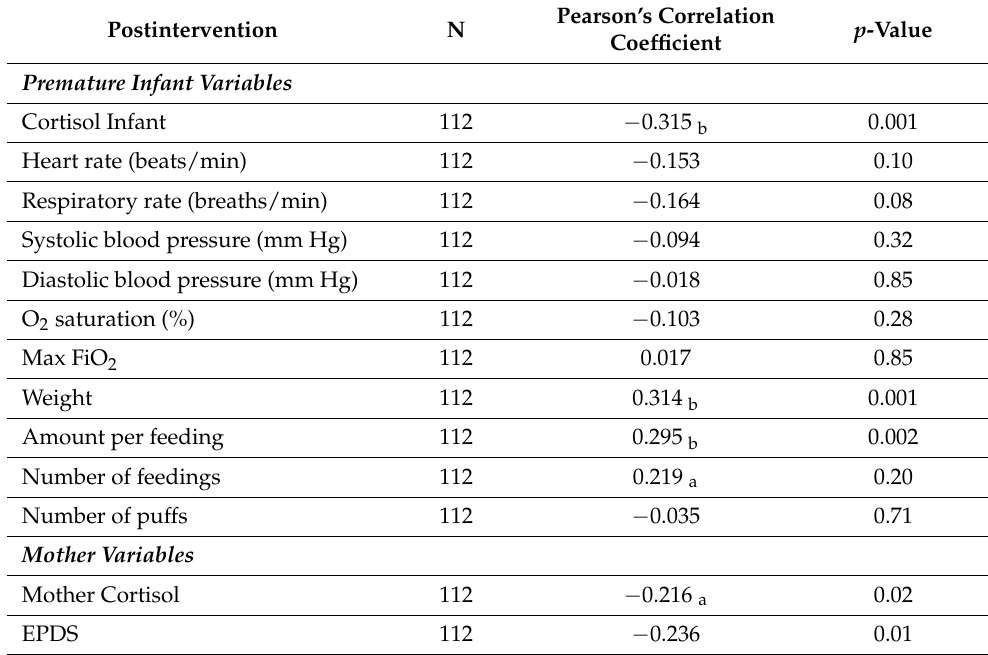
Table 3. Pearson’s correlation between the total duration (min.) of KMC and the outcomes of infant and maternal postintervention variables.